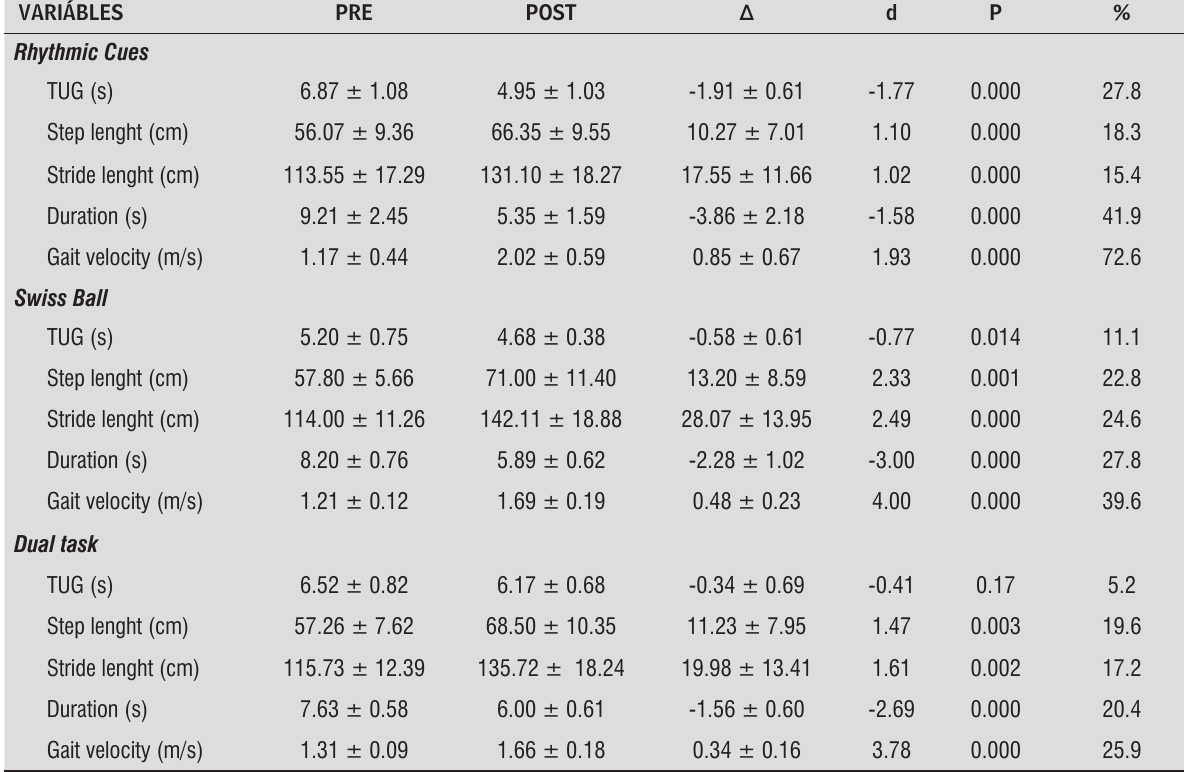
Table 2 - Intra-group